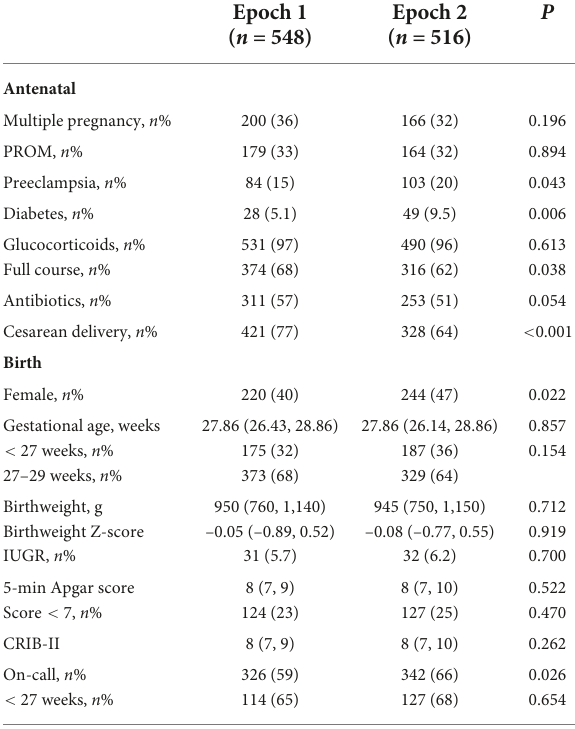
TABLE 3 Perinatal characteristics according to the epoch of